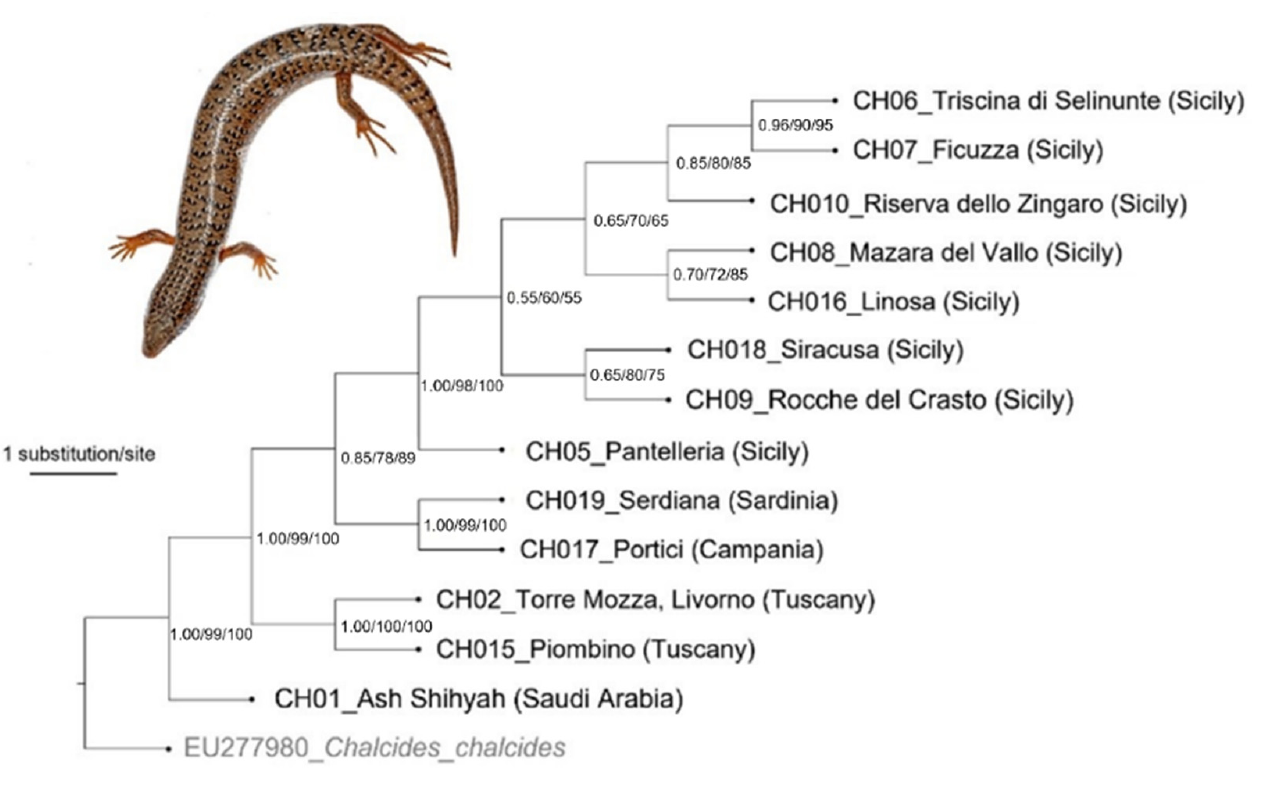
Figure 3. Maximum-likelihood phylogenetic tree of Chalcides ocellatus mtDNA sequences (three genes, Dataset 1). The numbers at nodes indicate Bayesian posterior probability, Maximum-Likelihood and Neighbor-Joining bootstrap values.